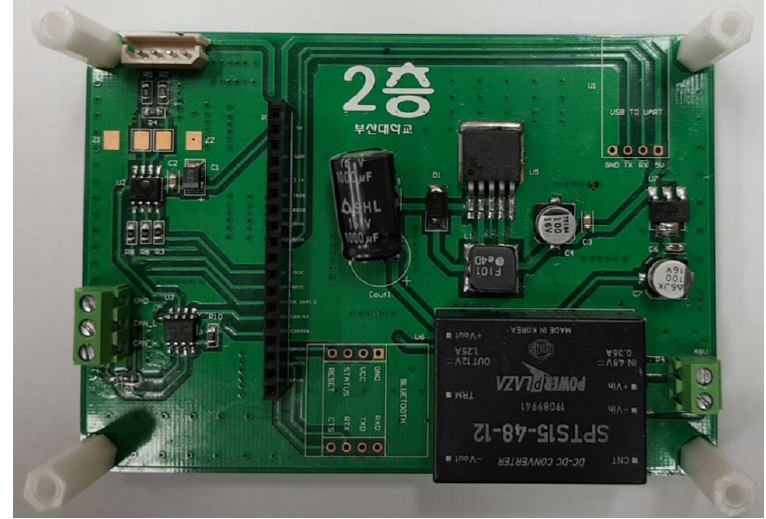
Figure 21. Bottom layer of Robot hand control module.